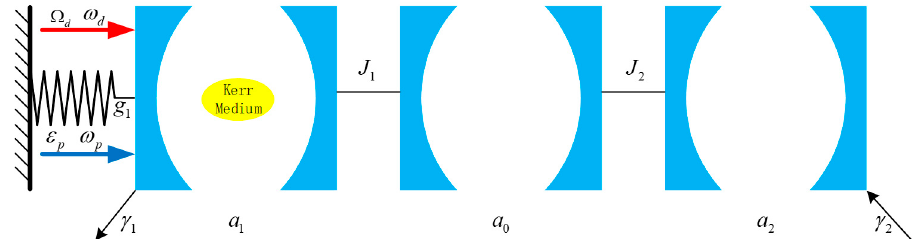
Figure 1. Schematic diagram of a hybrid cavity optomechanical system. It consists of three single- mode cavity arrays, a Kerr medium, and a mechanical oscillator. In addition, the passive cavity is driven by an external laser field and a weak probe field.